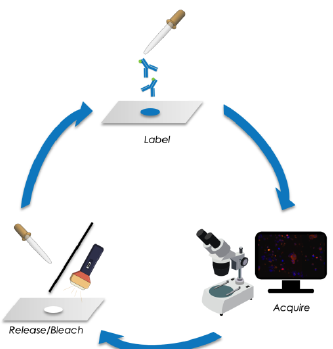
Figure 1. Schematic of sequential immunofluorescence staining followed by image acquisition and releasing/bleaching of fluorochromes. Table 2. Immunofluorescent staining of cell lines ZR75-1 and T98G as well as hematopoietic bone marrow cells for the six different markers used.